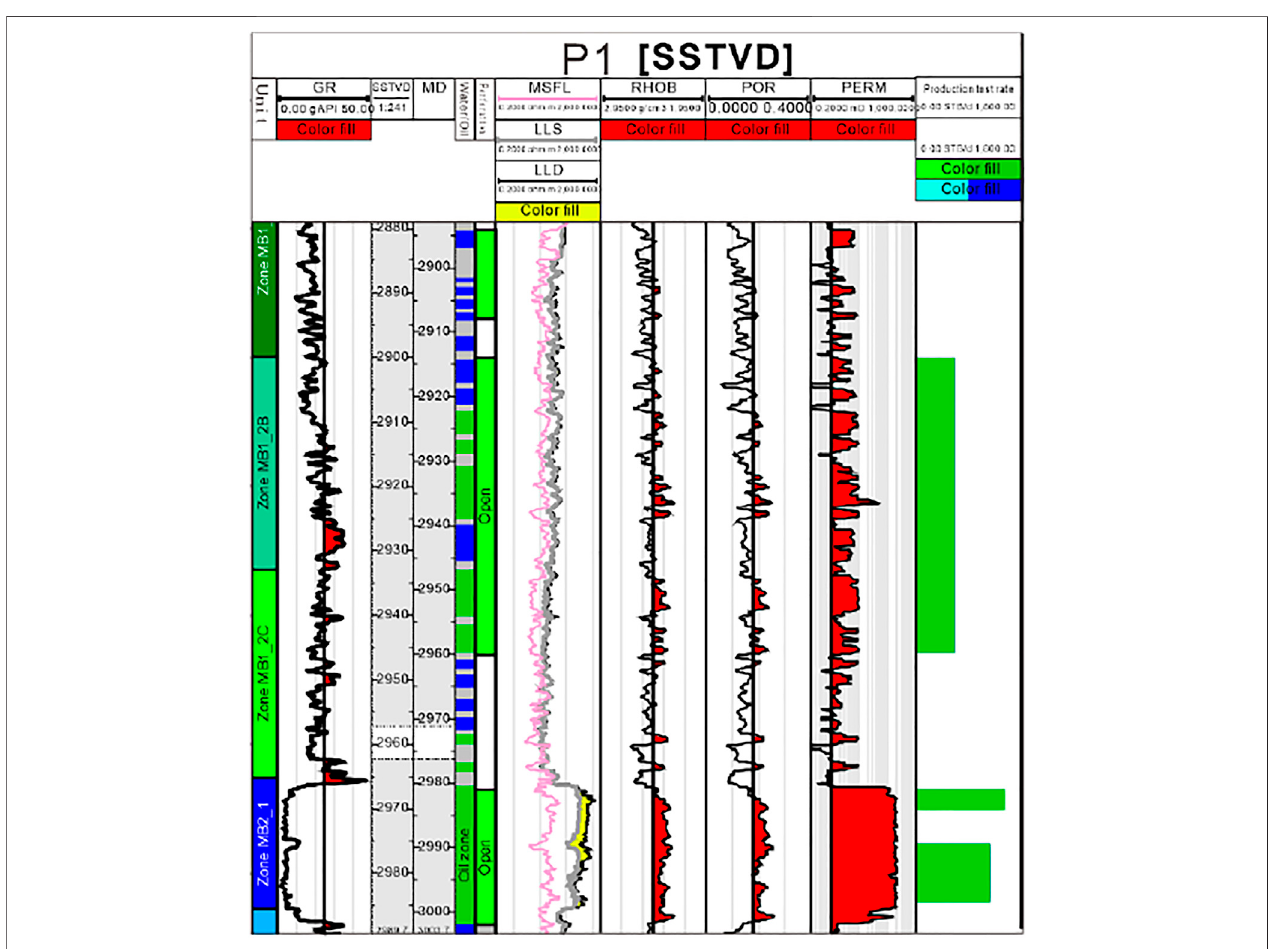
Frontiers in Energy Research |